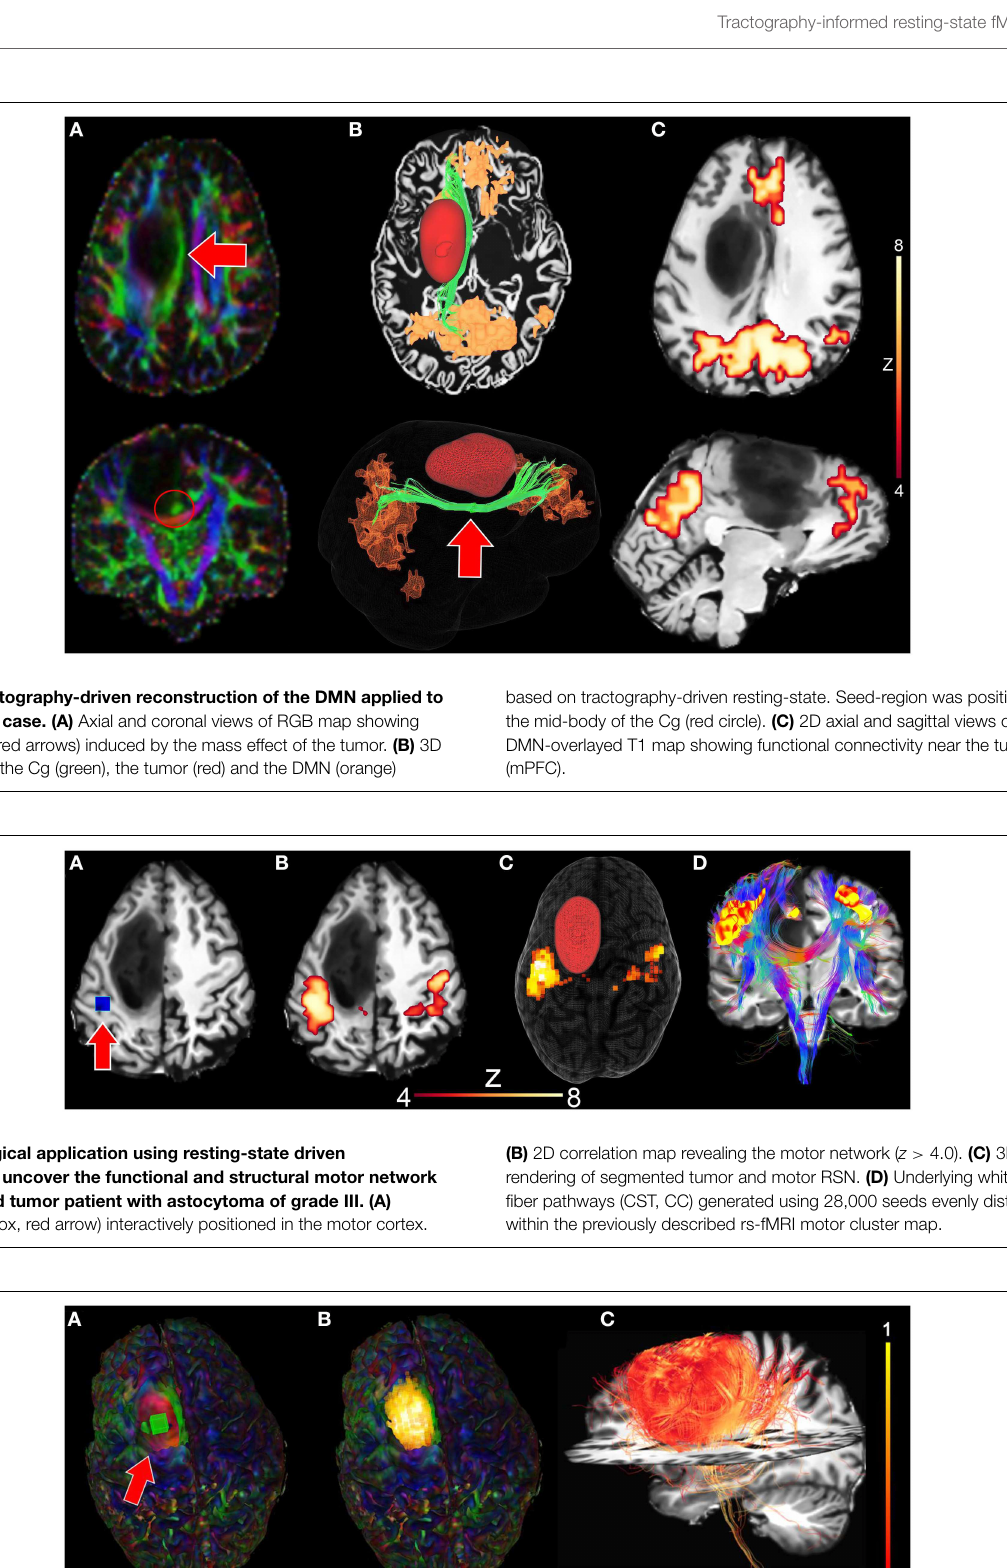
functional correlation within the tumor. (C) Fiber tractography generated using the functionally-segmented tumor mask showing structural organization in the vicinity of the tumor. Colormaps: (A,B) RGB, (C) FA.